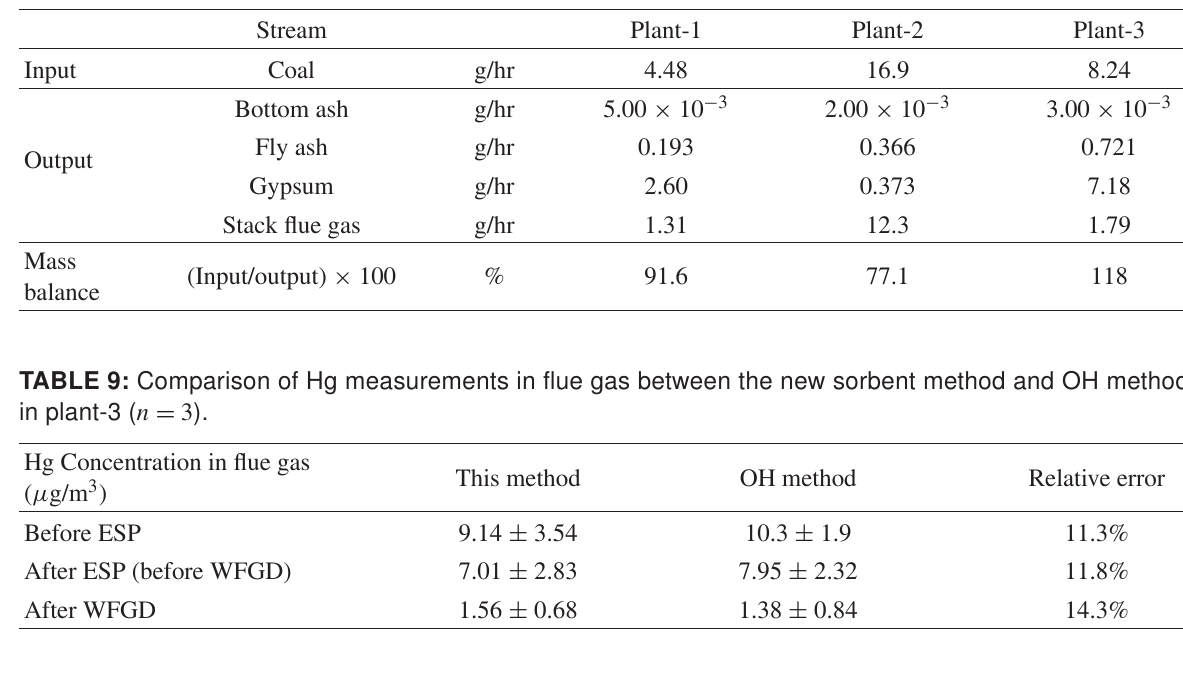
TABLE 8: Mass balances of Hg between input and output streams in three power plants ( n = 3 ).